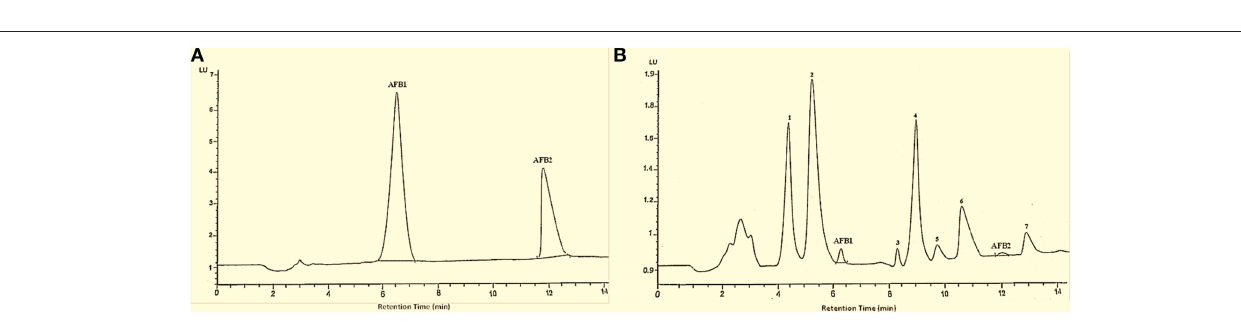
produced by Aspergillus flavus and Aspergillus parasiticus (Ellis et al., 1991; Bhatnagar et al., 1992). The G series of aflatoxins differs chemically from B series by the presence of a β lactone ring, instead of cyclopentenone ring. In AFB1 and AFG1 a double bond undergoes reduction forming vinyl ether at the terminal furan ring but not in AFB2 and AFG2 (Samarajeewa et al., 1990). AFB1 and AFG1 are carcinogenic and considerably more toxic than AFB2 and AFG2 probably due to these small difference in structure (Jaimez et al.,